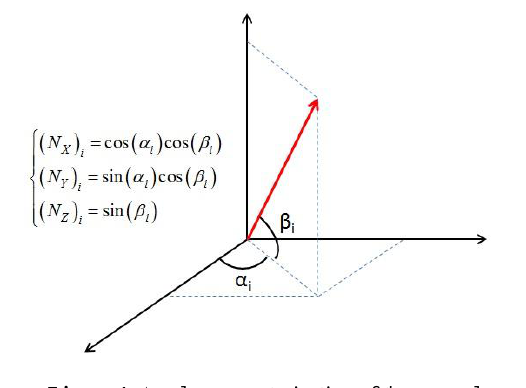
Figure 4: Angle parameterization of the